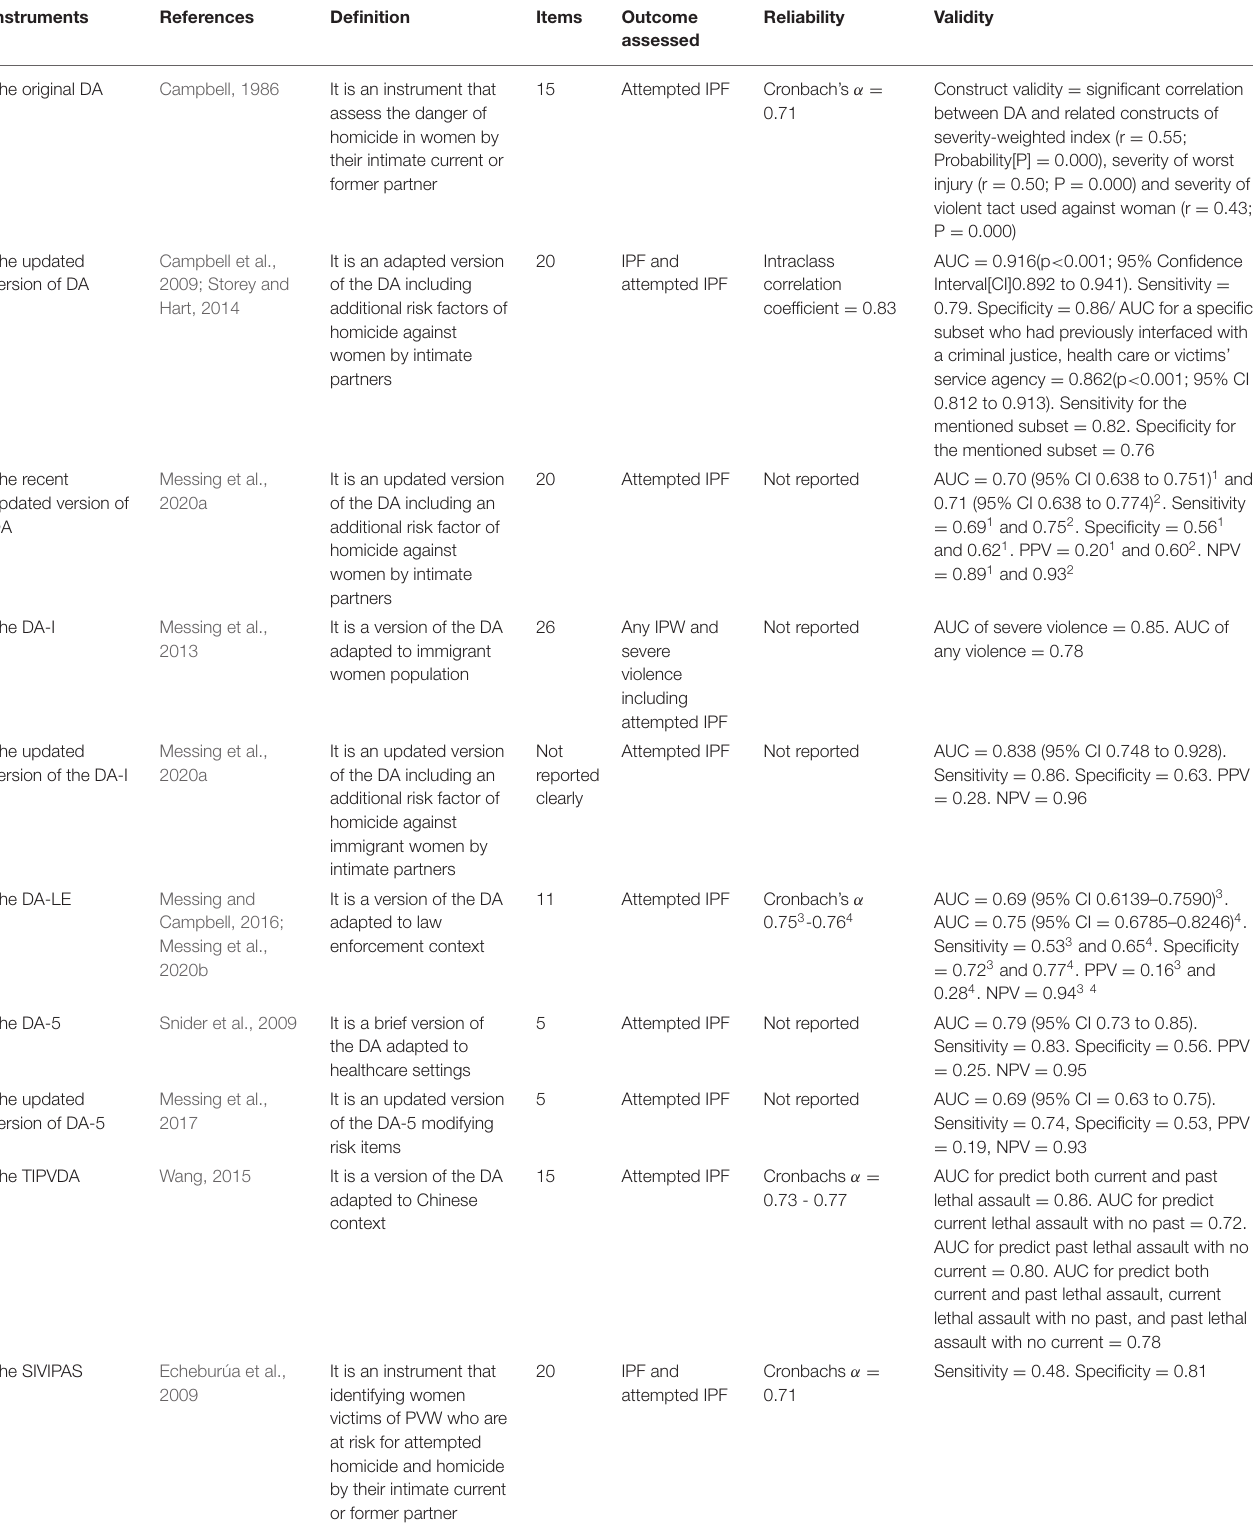
TABLE 2 | Risk asssessment instruments for